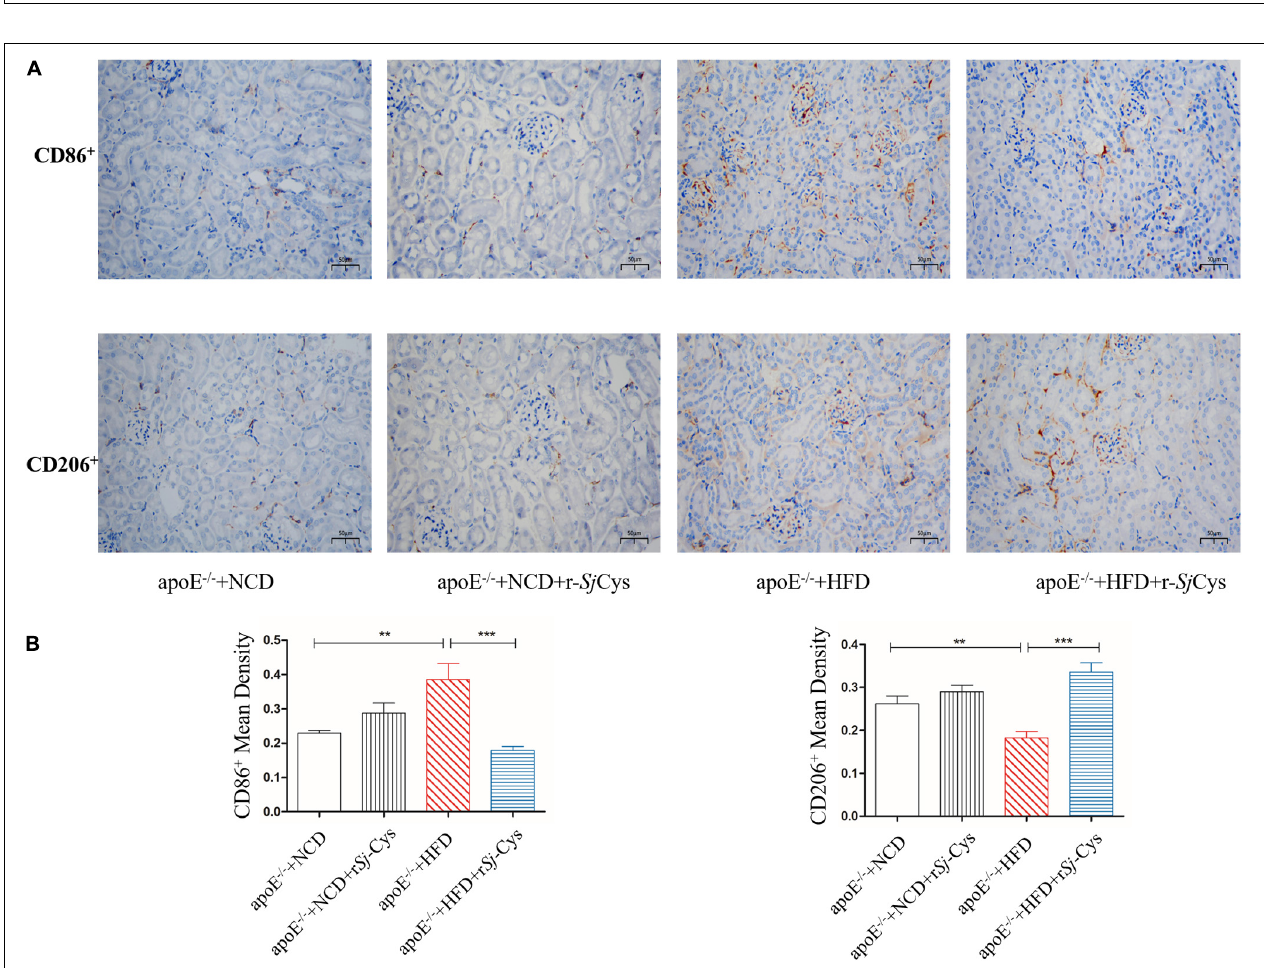
FIGURE 7 | (A) Representative immunohistochemistry staining of CD86 + and CD206 + expression in sections of the kidney from different groups of mice ( × 200, scale bar 50 µ m). (B) r Sj -Cys reduced the mean density of CD86 + and increased the mean density of CD206 + . The results are shown as the mean ± SEM for each group ( n = 6 per group). ** P < 0.01, *** P < 0.001.